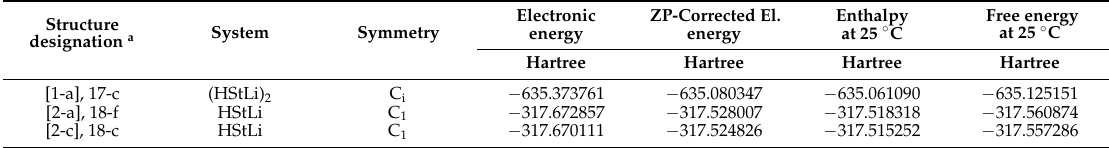
Table A3. Calculated energies in THF for (HStLi) 2 (1-a), HStLi(2-a) and